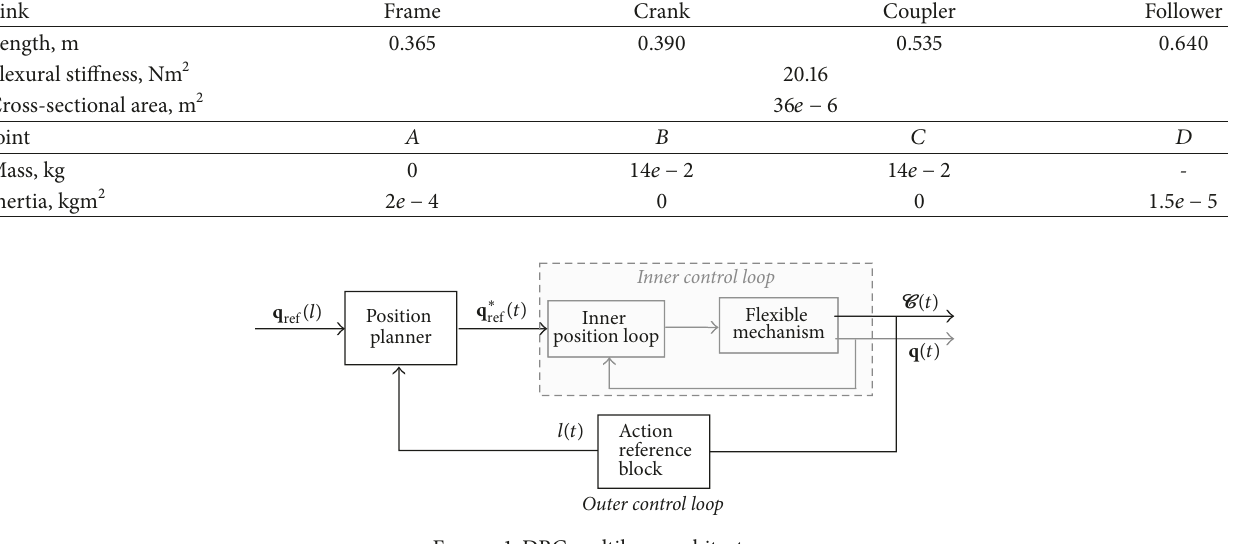
Figure 1: DRC multiloop architecture.